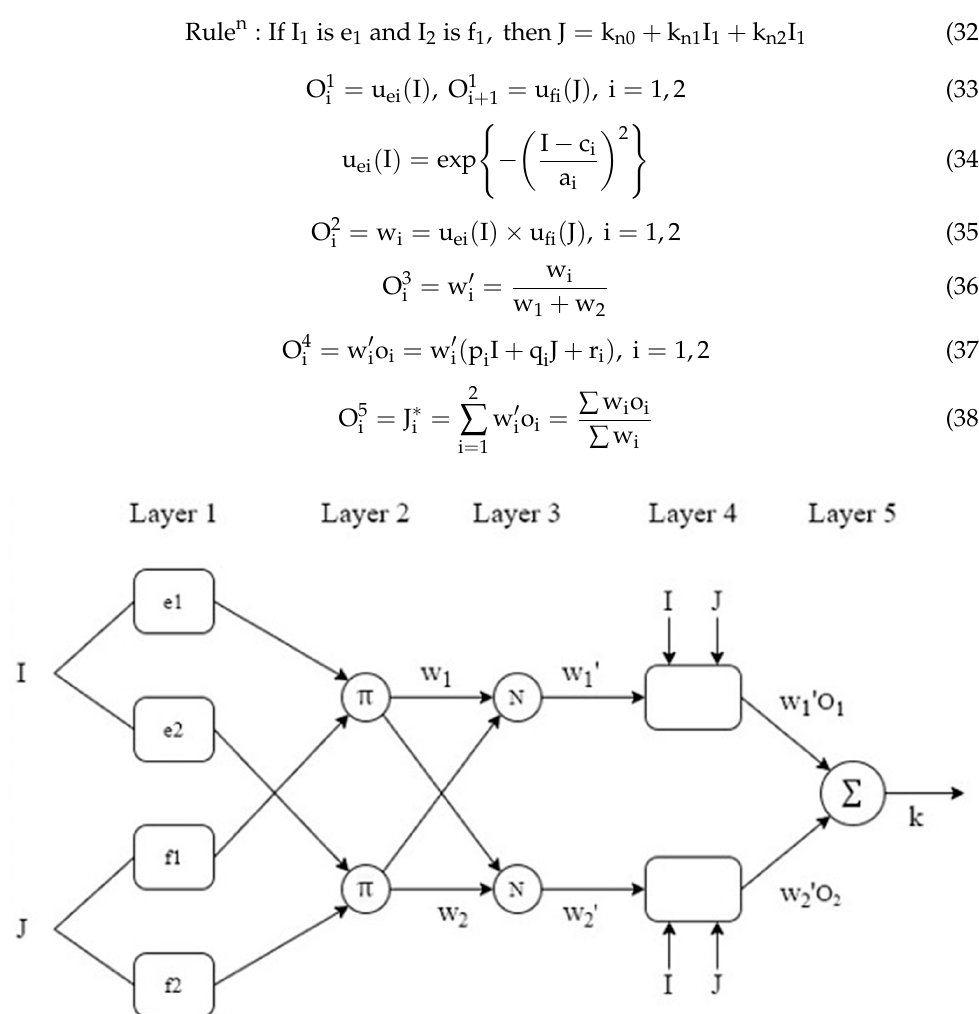
Figure 14. Structure of